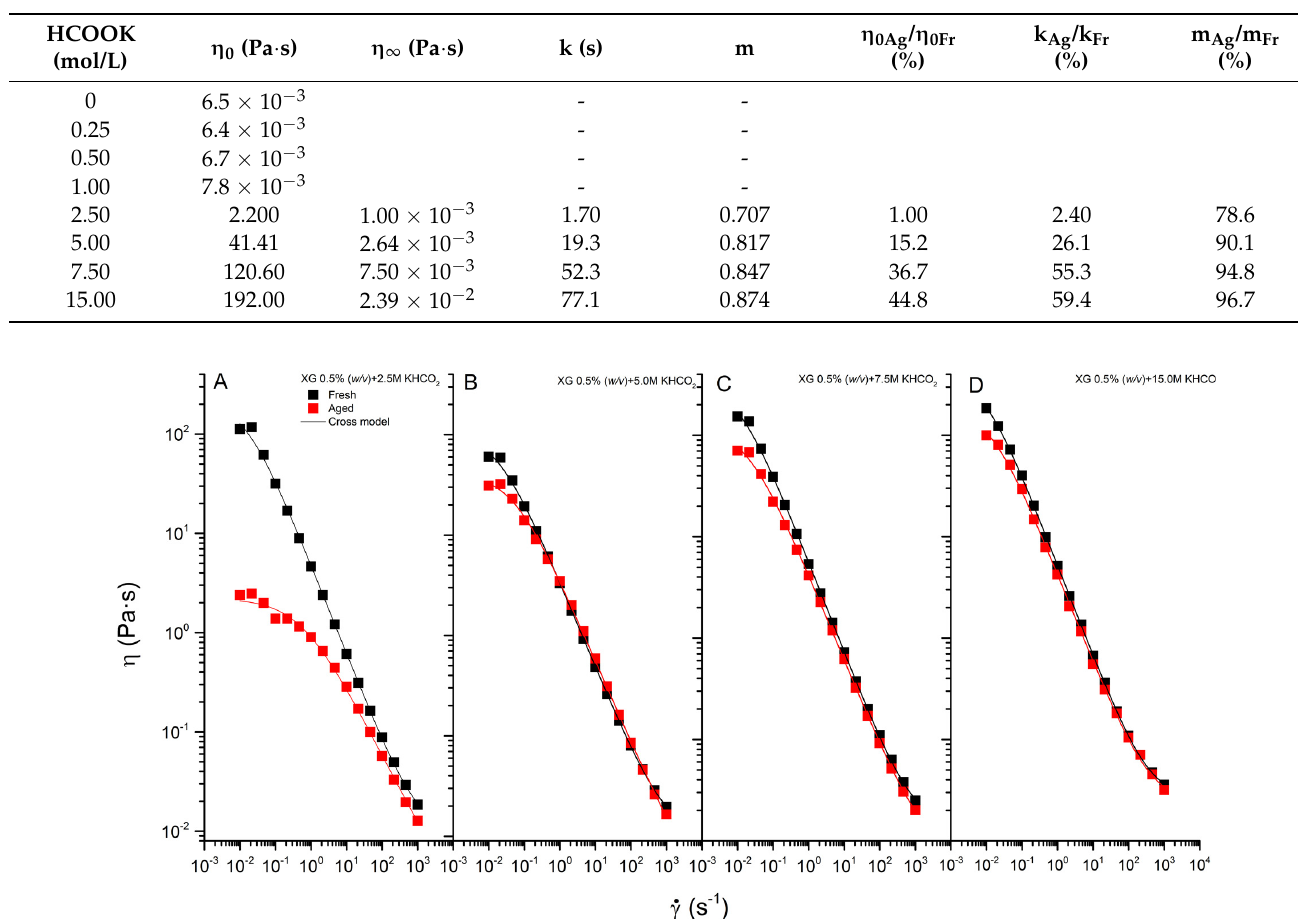
Figure 4. Effect of aging on the flow behavior for XG 0.5% ( w/v ) in potassium formate 2.50 M ( A ), 5.00 M ( B ), 7.50 M ( C ), and 15.00 M ( D Table 2. Cross model parameters for aged samples XG 0.5% ( w/v ) as a function of the formate con- centration.